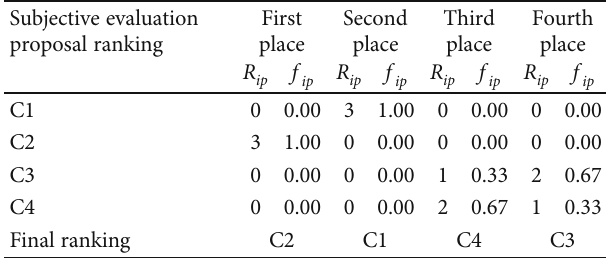
Table 2: Correlation analysis data 2.